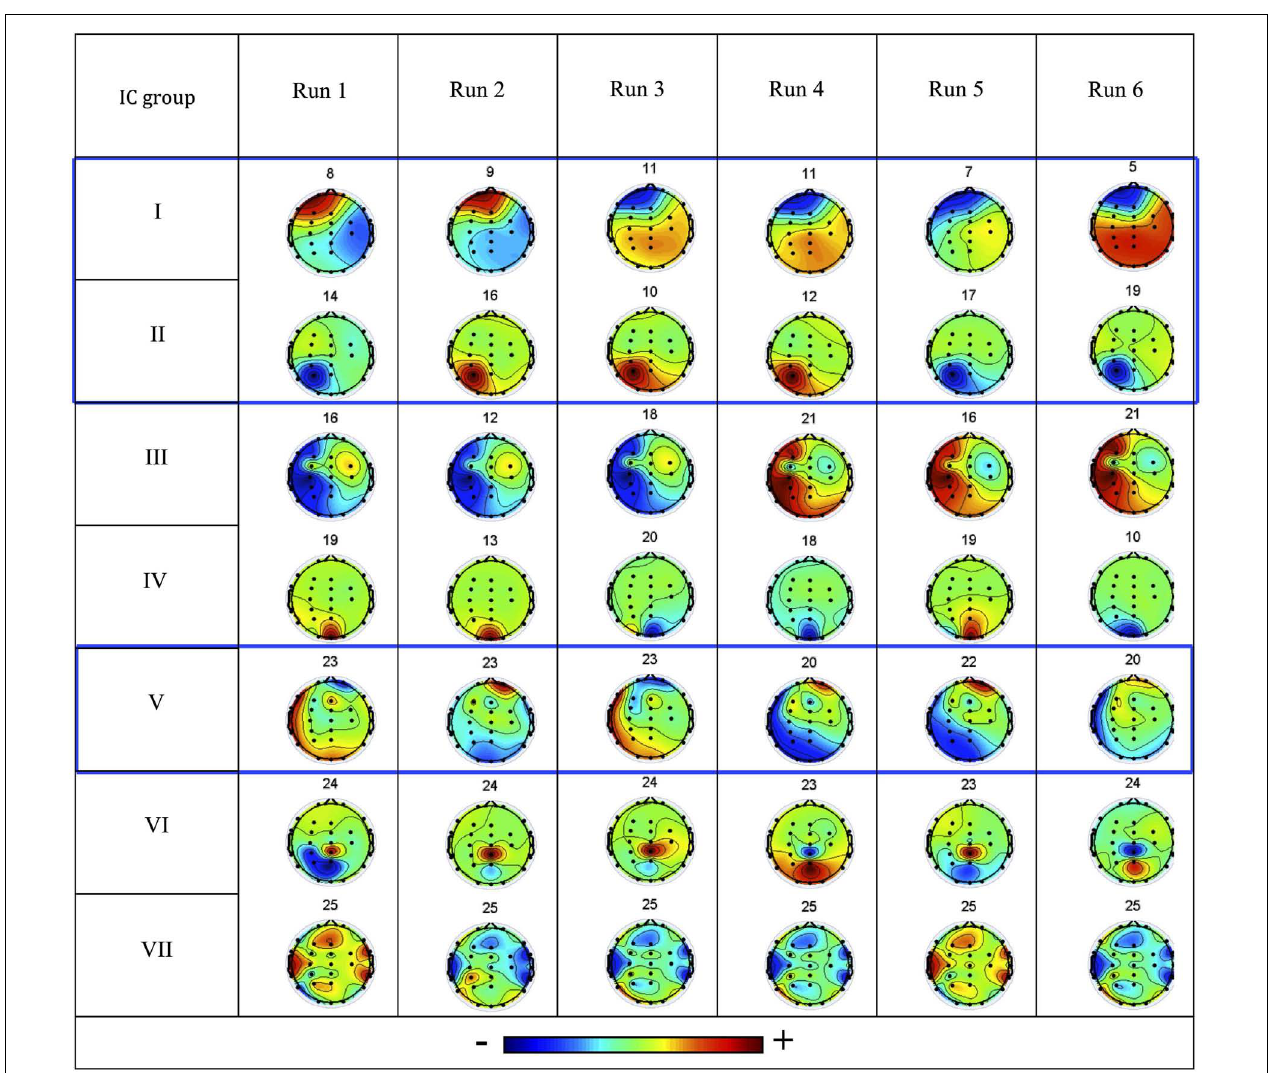
FIGURE 2 | Consistent IC groups I–VII: the associated IC topographies for each run are shown (color scale indicates relative weight of each EEG channel), together with the respective IC number. The three IC groups highlighted in blue boxes were considered not artifactual and hence of interest (left is left, right is right, up is anterior, down is